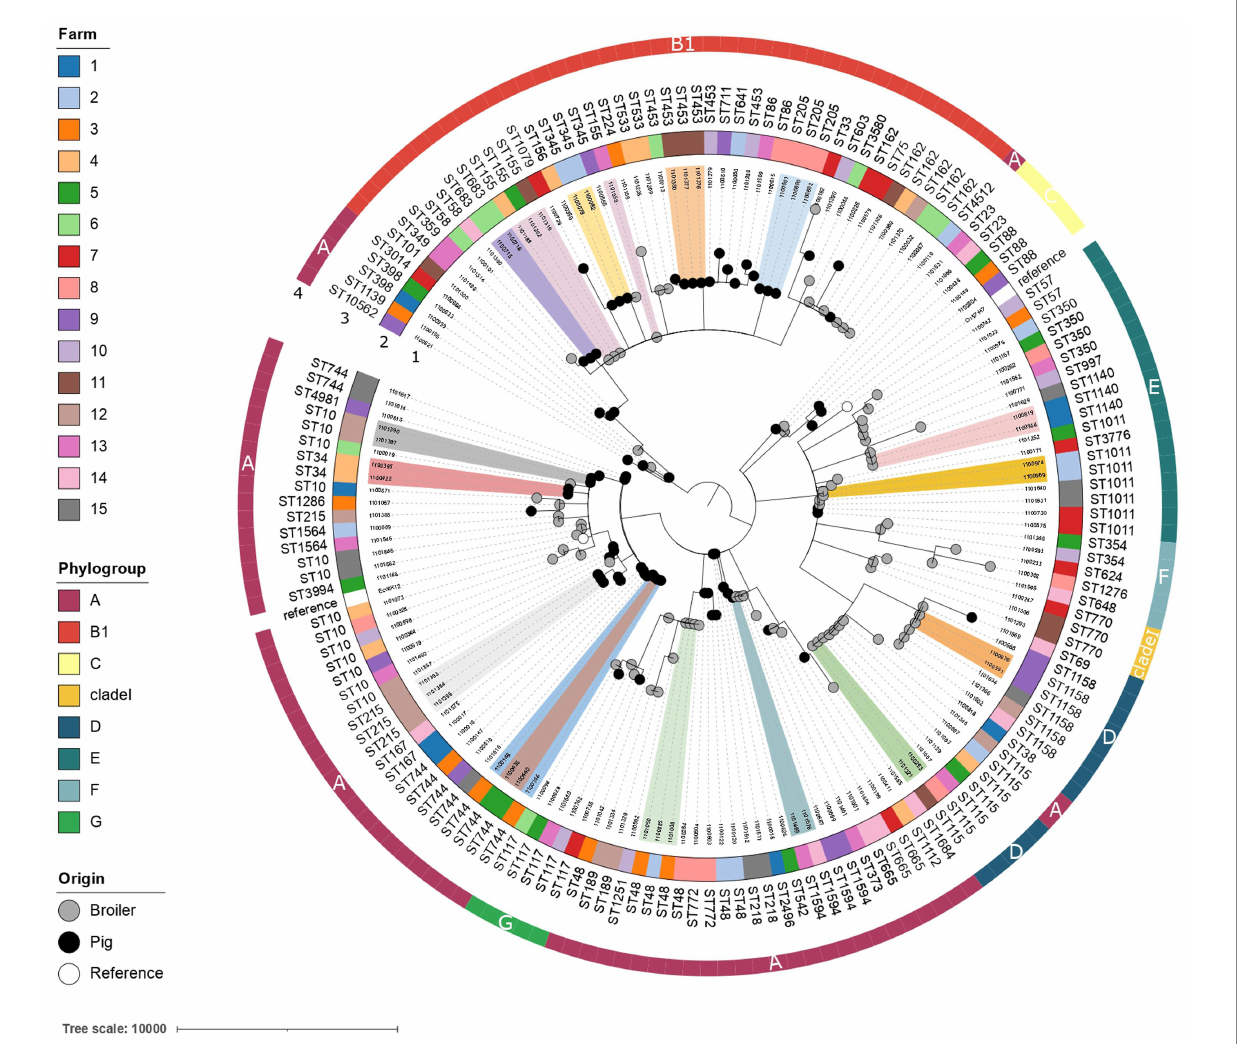
FIGURE 6 Phylogenetic tree of ciprofloxacin-resistant and ESBL-producing E. coli from broilers and pigs. The minimum spanning tree is distance-based and was generated by iTOL using cgMLST profile data (3,012 loci). Colored clusters indicate genetically related isolates with ≤ 10 allelic differences from different broilers/pigs. The isolate IDs are shown in the first ring. The farm is indicated in colored strips in the second ring. Achtmann ST and phylogroups are indicated in rings three and four, respectively. The origin of the isolate is indicated with black (pig), grey (broiler) or white ( E. coli K12 and E. coli O157-H7 reference strains)